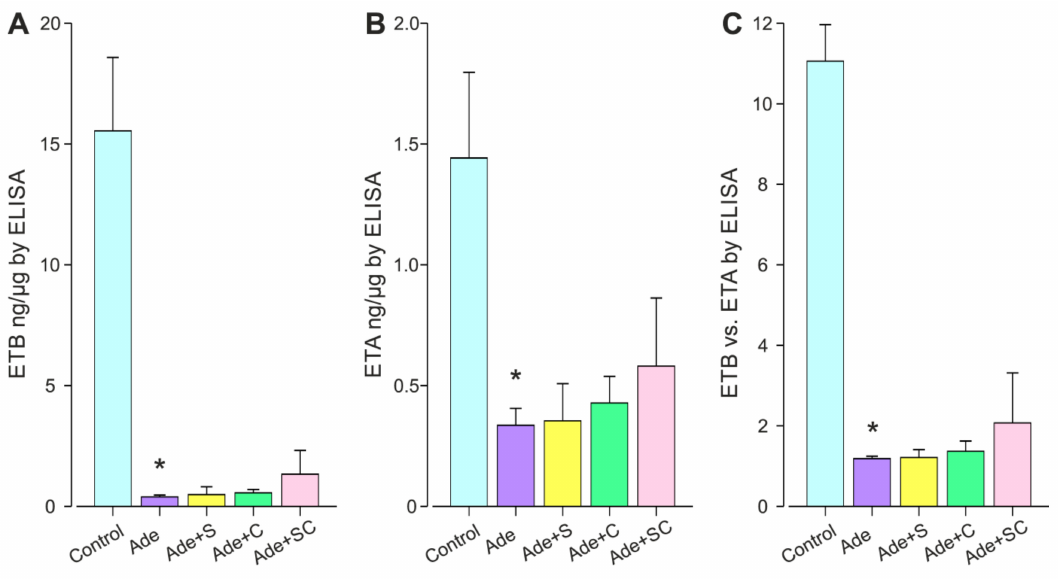
Figure 4. Kidney ETB ( A ) and ETA ( B ) receptor protein content, and the ETB:ETA receptor protein ratio ( C ) quantified using ELISA in the twelve-week adenine model; Control, control diet; Ade, 0.3% adenine diet; S, sitaxentan50 mg / kg / day; C, cinacalcet 20 mg / kg / day; SC, sitaxentan + cinacalcet; n = 12–20 / group. Values are mean ± 95% confidence interval of the mean. * p < 0.05 vs.